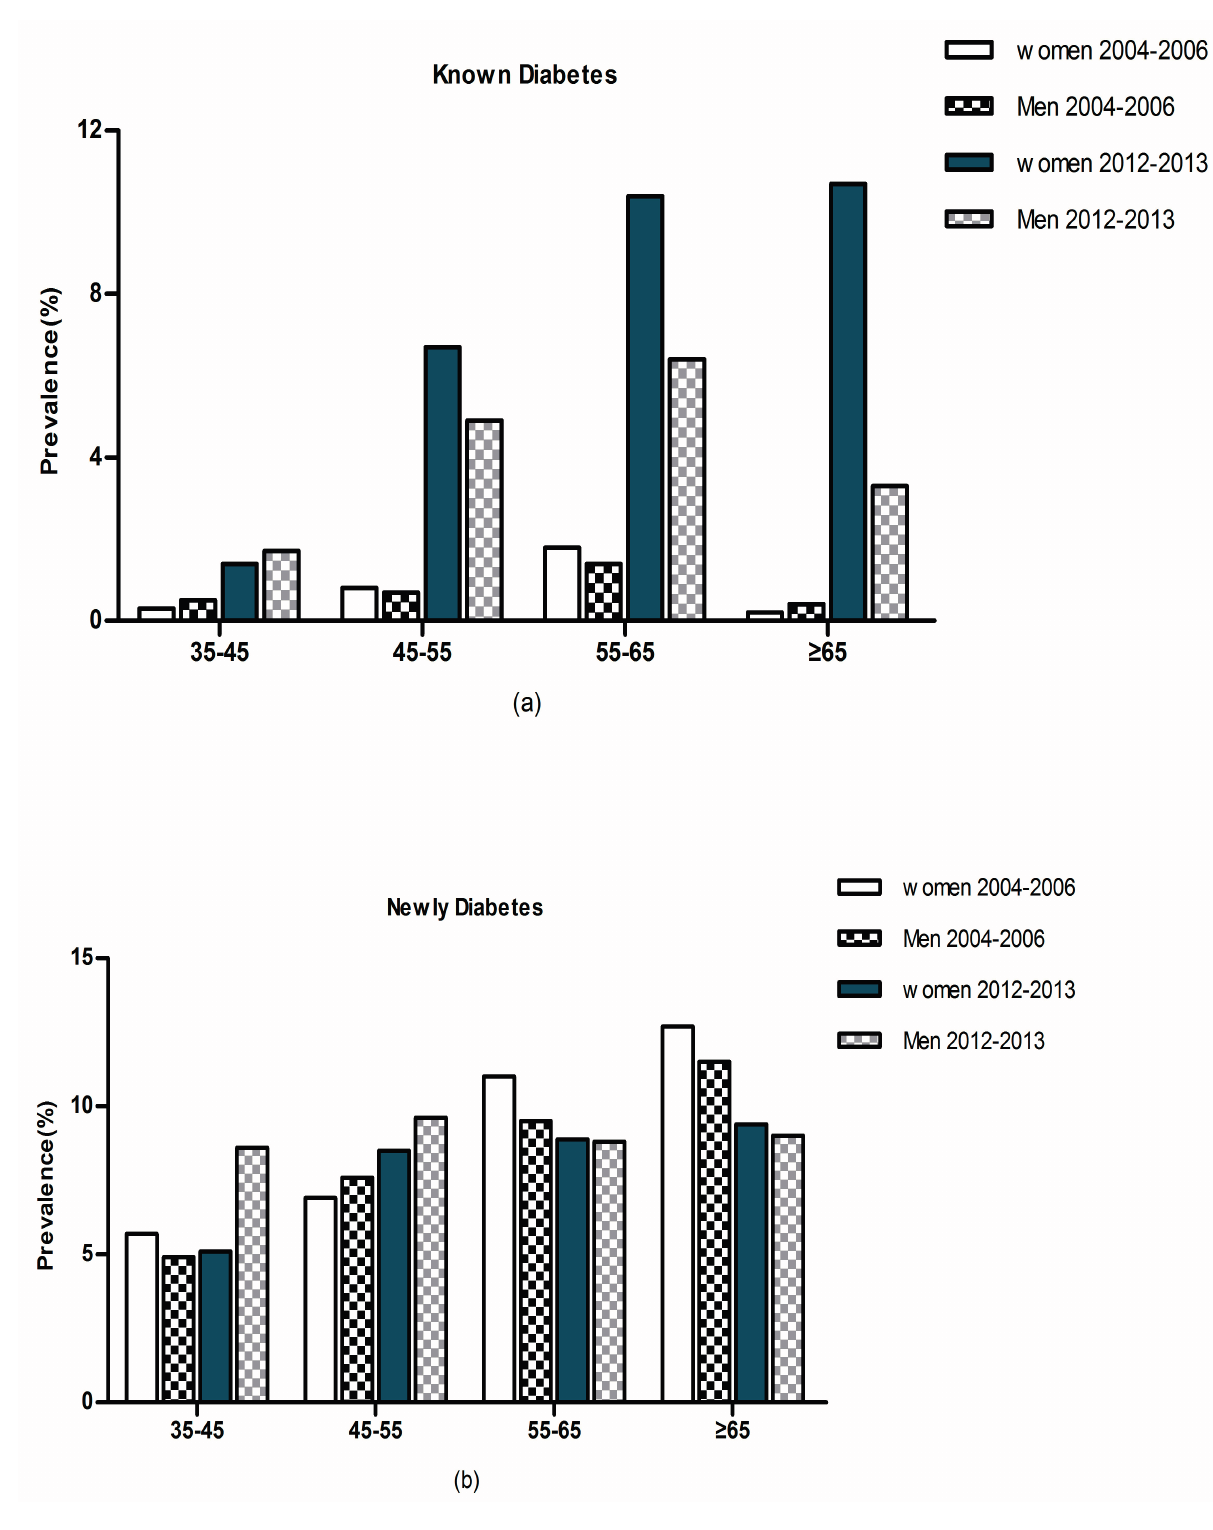
Figure 1. Prevalence of ( a ) known diabetes, ( b ) newly diagnosed diabetes, by gender and age from 2004–2006 years to 2012–2013 years in hypertensive subjects in rural Northeast